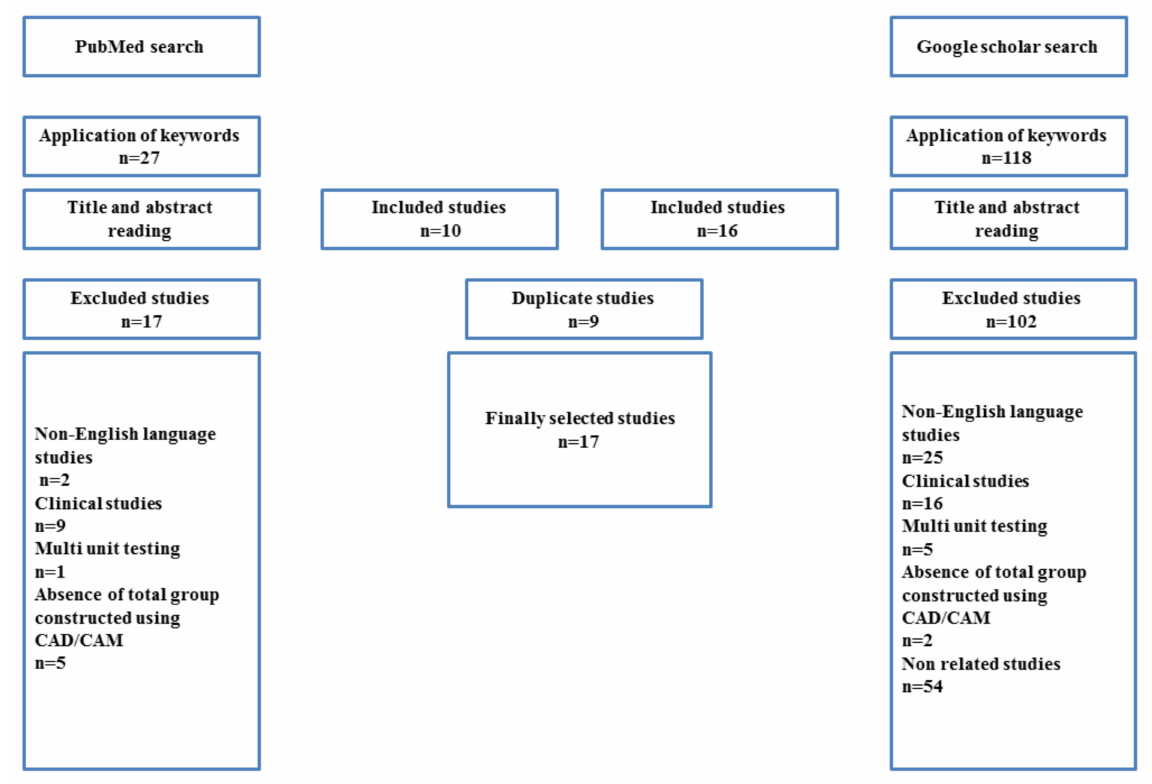
Figure 1. Flow diagram for the search strategy and selection process for the included